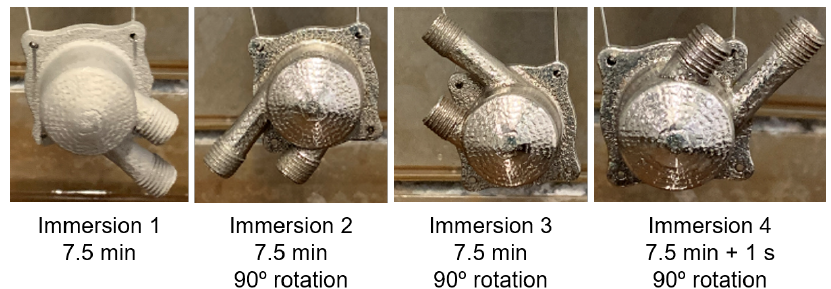
Figure 2. Photographs of the upper part of a metallic 3D-printed mist chamber, showing the PEP immersion sequence and time. In total, every part was plasma-polished for 30